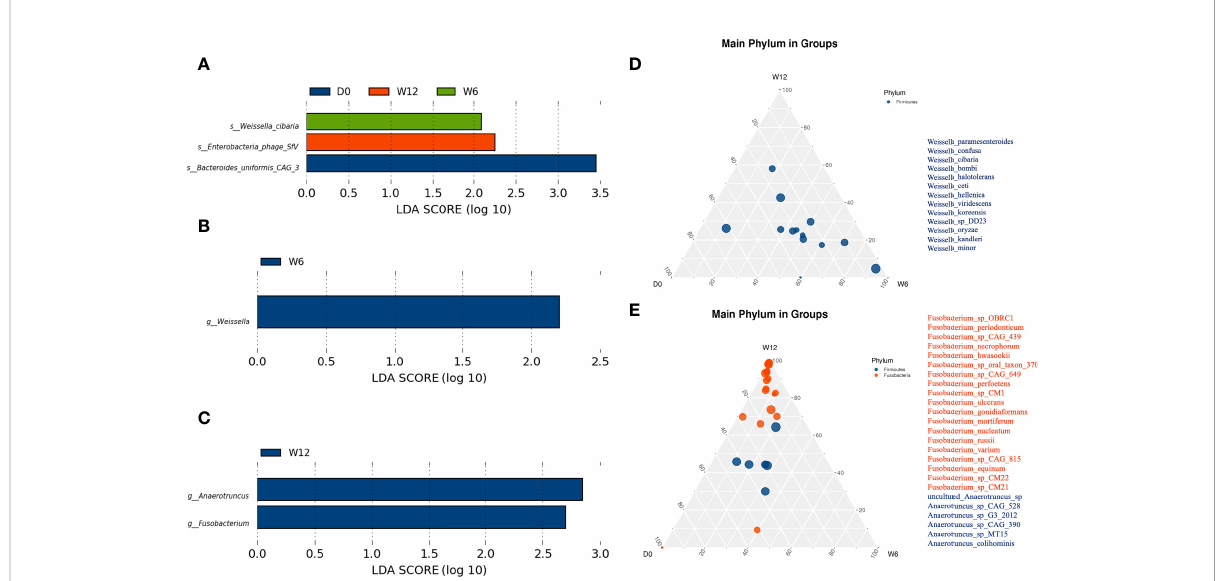
FIGURE 5 Dynamic analysis of the gut microbiota longitudinally. (A) Differential species in the R group (n = 16) at baseline, 6 weeks, and 12 weeks. (B, C) Differential genera in the R group (n = 16) and the NR group (n = 8 at 6 weeks, n = 3 at 12 weeks). (D, E) At the genus level, signi fi cantly different species were identi fi ed by ternary plots between the R group (n = 16) and NR group (n = 8) at 6 weeks.